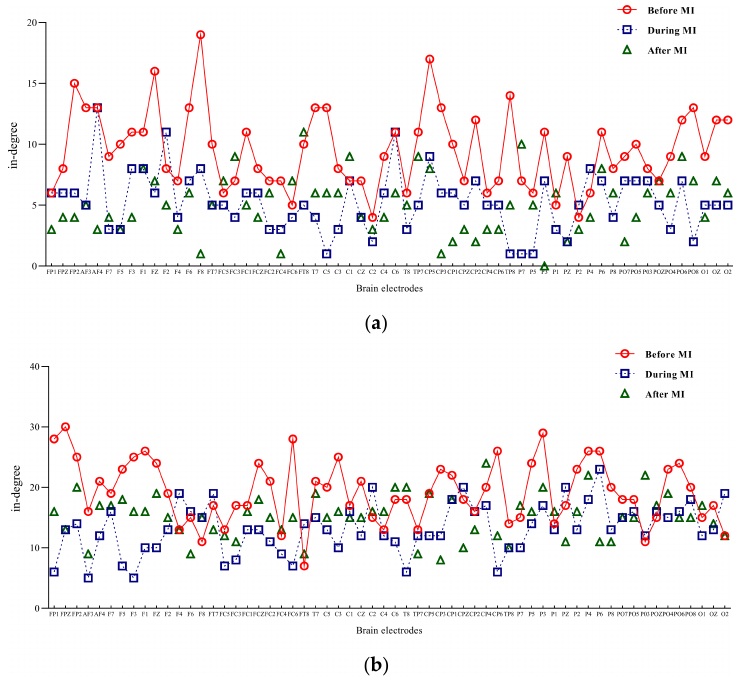
Figure 4. Mu/beta in degree of three different states of motor imagery. ( a ) Mu-rhythm in degree of three different states of motor imagery. ( b ) Beta-rhythm in degree of three different states of motor imagery.